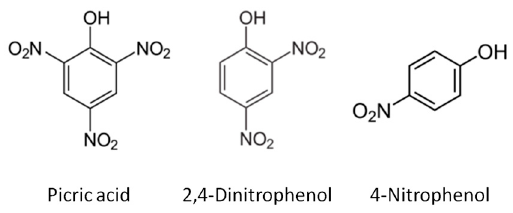
Figure 1. Chemical structures of picric acid, 2,4-dinitrophenol, and 4-nitrophenol.